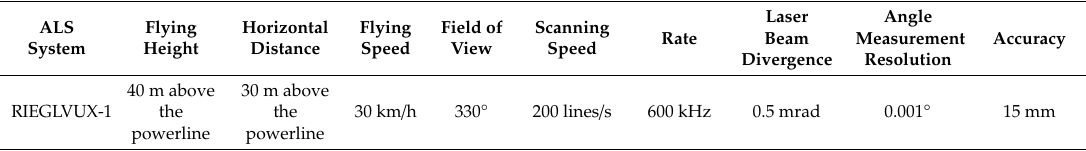
Table 4. Details about data